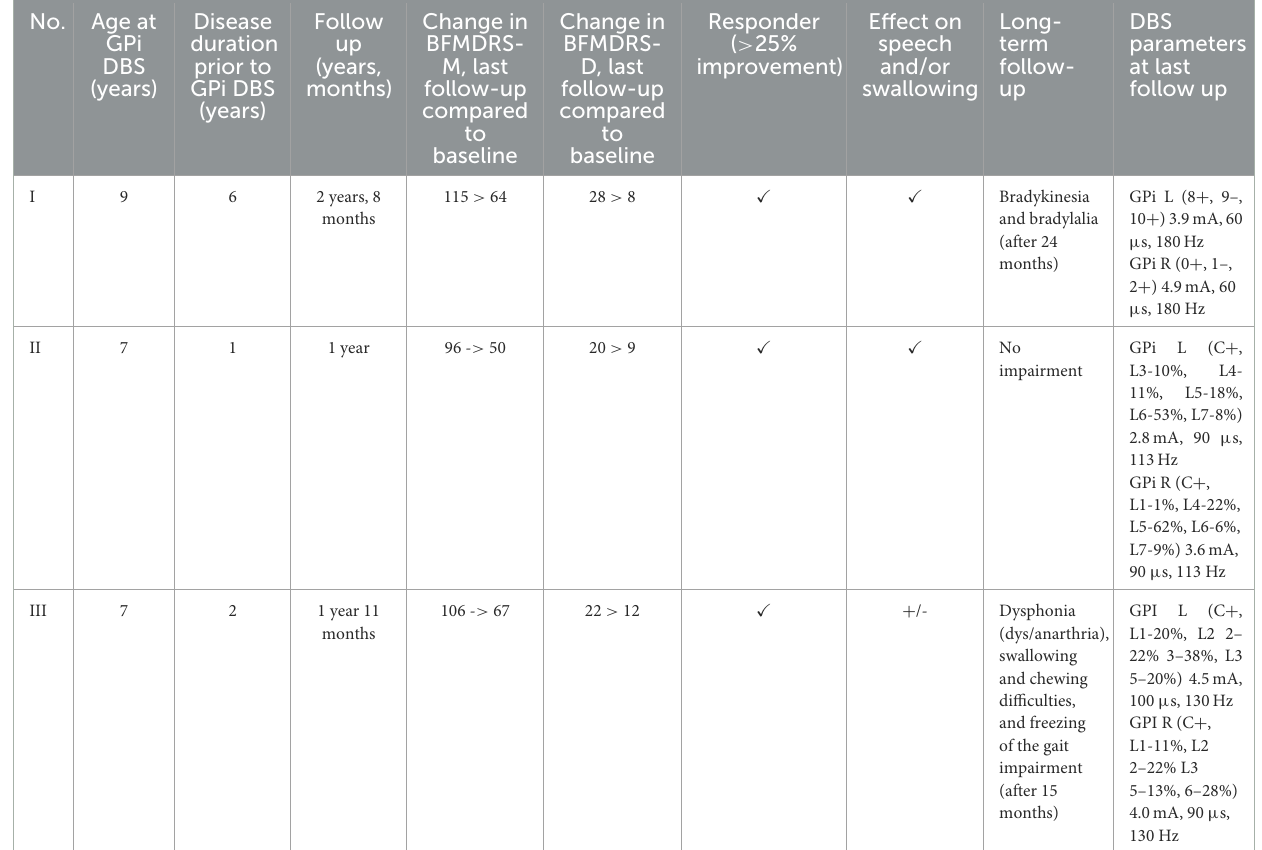
Effect on speech and/or swallowing